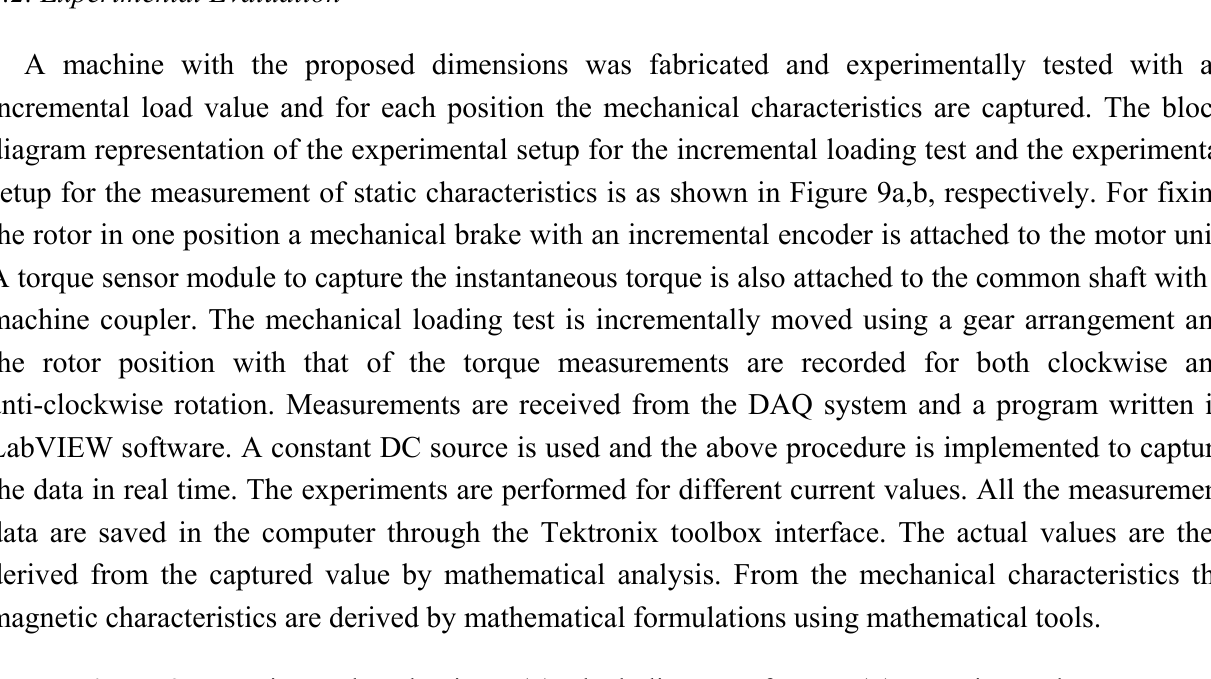
Figure 9. Experimental evaluations: ( a ) Block diagram of setup; ( b ) Experimental